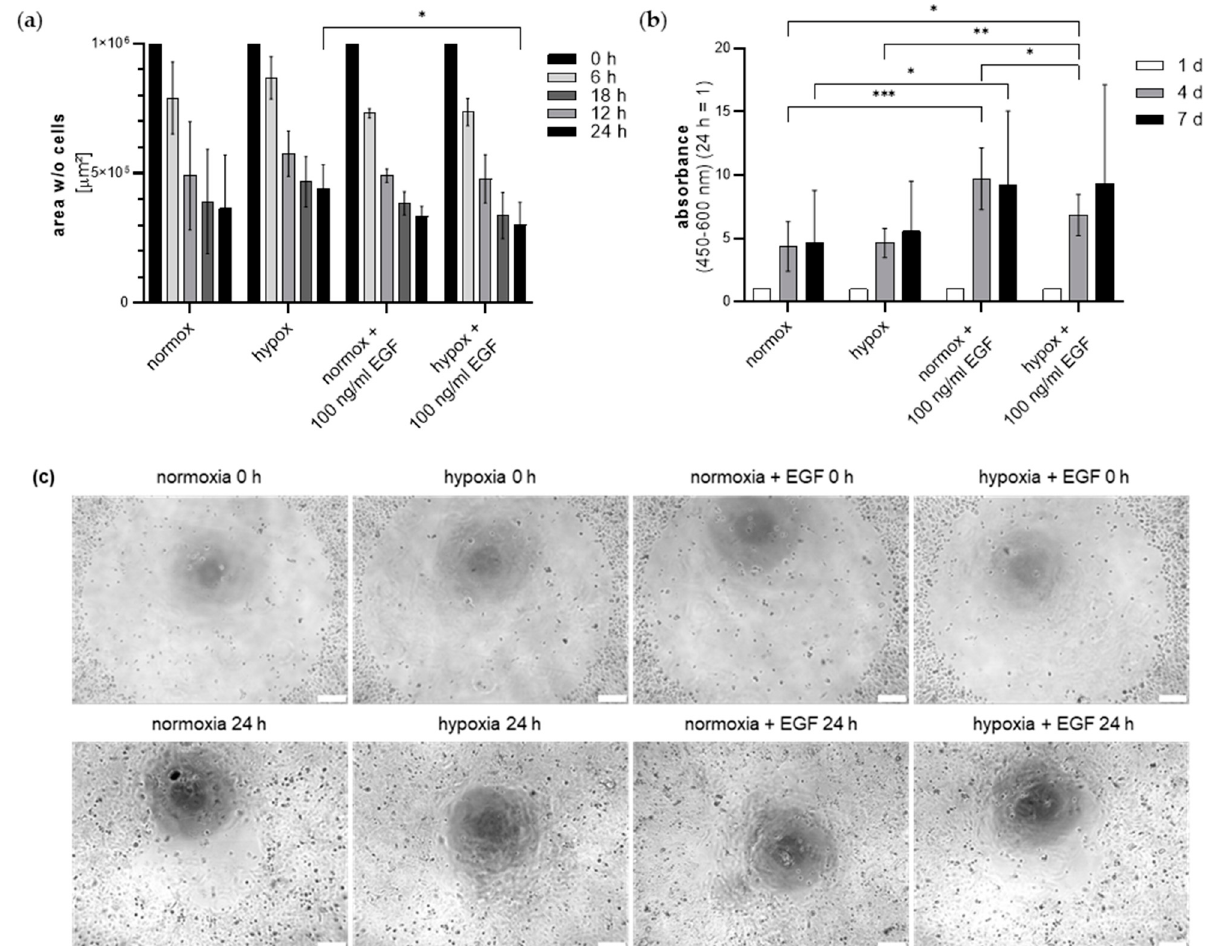
Figure 6. Effect of ADSC secretome from ADSC cultivated in normoxia or hypoxia with or without EGF supplementation on keratinocyte migration and viability. ( a ) Migration of keratinocytes depicted as cell-free area over 24 h. ( b ) Keratinocyte viability measured by WST-8 over 7 days. Values were calculated relatively (24 h = 1). ( n = 3, technical triplicates, * p ≤ 0.05, ** p ≤ 0.01, *** p ≤ 0.005). ( c ) Representative images of keratinocyte migration after 0 h and 24 h. Scale bar 200 µm.